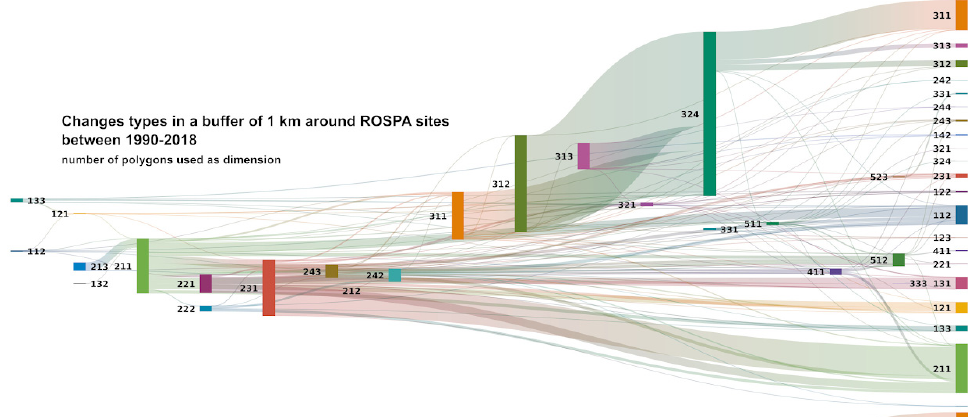
Figure 15. Land cover change dynamic in ROSPA sites, between 1990–2018.